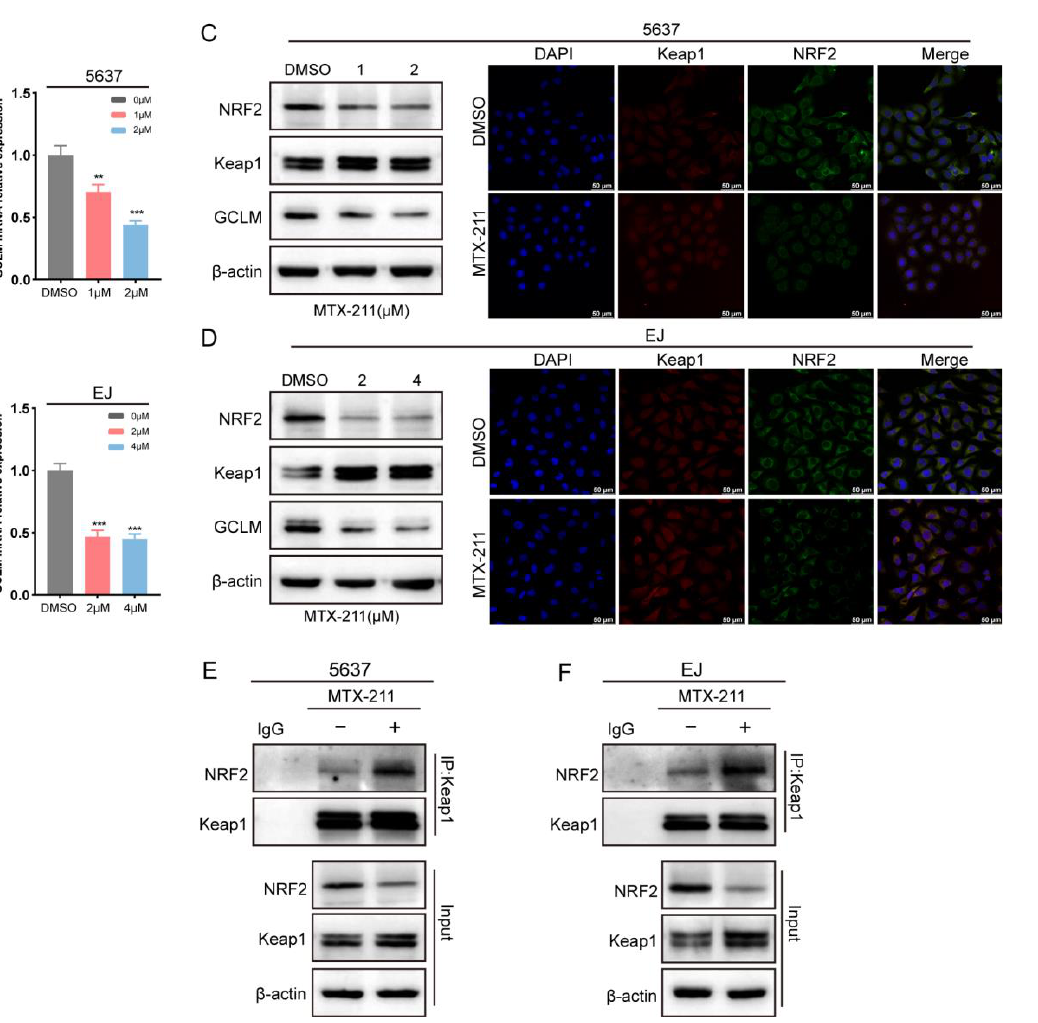
Figure 5. MTX-211 inhibits the Keap1/NRF2/GCLM signaling pathway. ( A , B ) The mRNA expression level of GCLM. ( C , D ) The expression levels of Keap1, NRF2, and GCLM were detected using Western blot and immunofluorescence analysis, which suggest Keap1 and NRF2 colocalized in 5637 and EJ cells. ( E , F ) Co-immunoprecipitation revealed that MTX-211 facilitated the binding of Keap1 to NRF2 proteins. ** p < 0.01, *** p < 0.001. Scale bar: 50 μm .